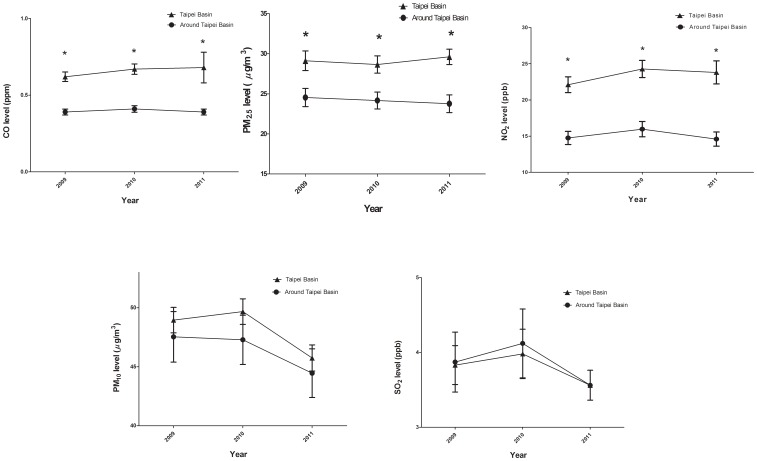
Analyzed the data base from the Taiwan Air Quality Monitoring Network (TAQMN) operated by the Environmental Protection Administration (EPA)and cited the report from the air quality status in Taiwan for the year 2009 to 2011.The mean concentrations of PM2.5, NO2 and CO were significantly high in Taipei Basin during these 3 years. *, significant difference, P<0.05.